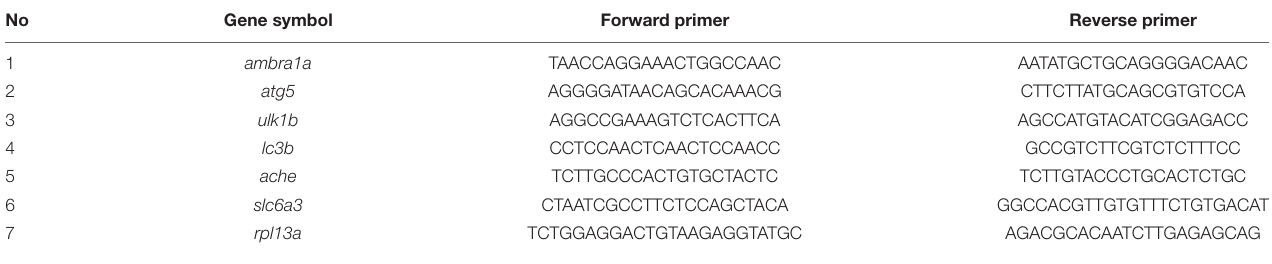
TABLE 1 | The sequences of primer pairs used in real-time quantitative PCR